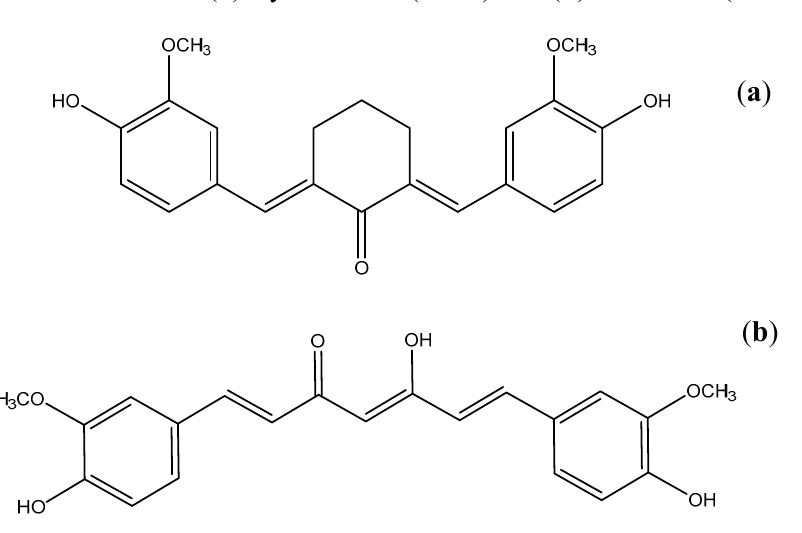
Figure 1. Structure of ( a ) Cyclovalone (CYV) and ( b ) Curcumin